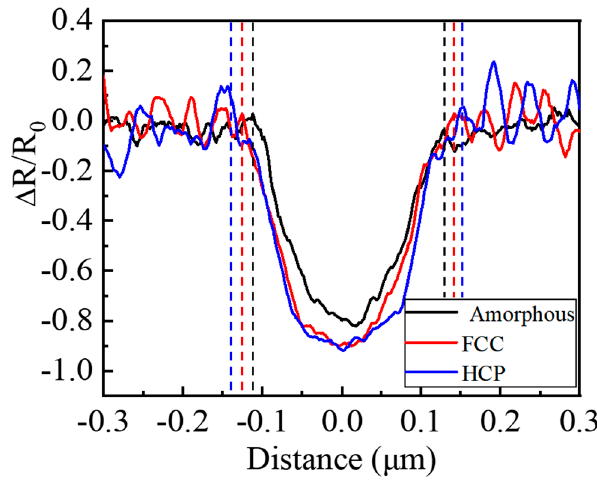
Figure 5. The extracted curve of the spatial reflectivity distributions at the short axis of the irradiated elliptical focal area at the delay time of 100 ps.